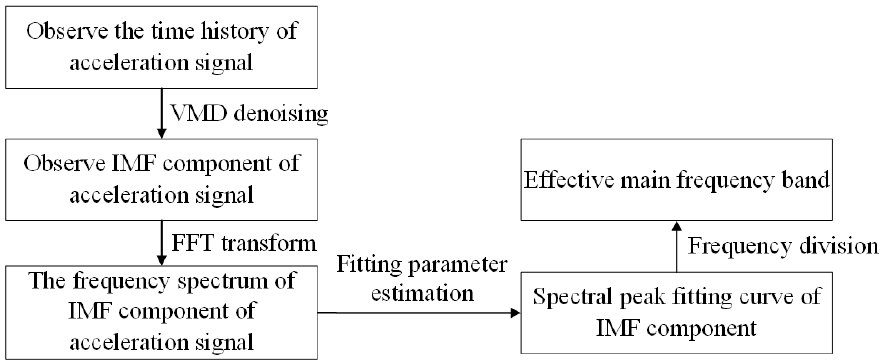
Figure 9. Flow chart of denoising